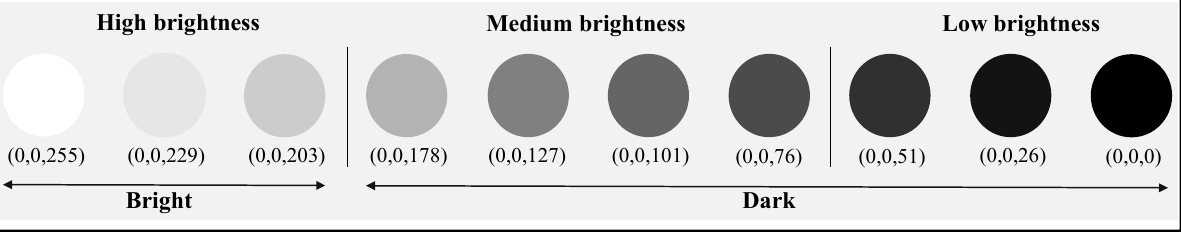
Figure 4. Criteria of brightness.